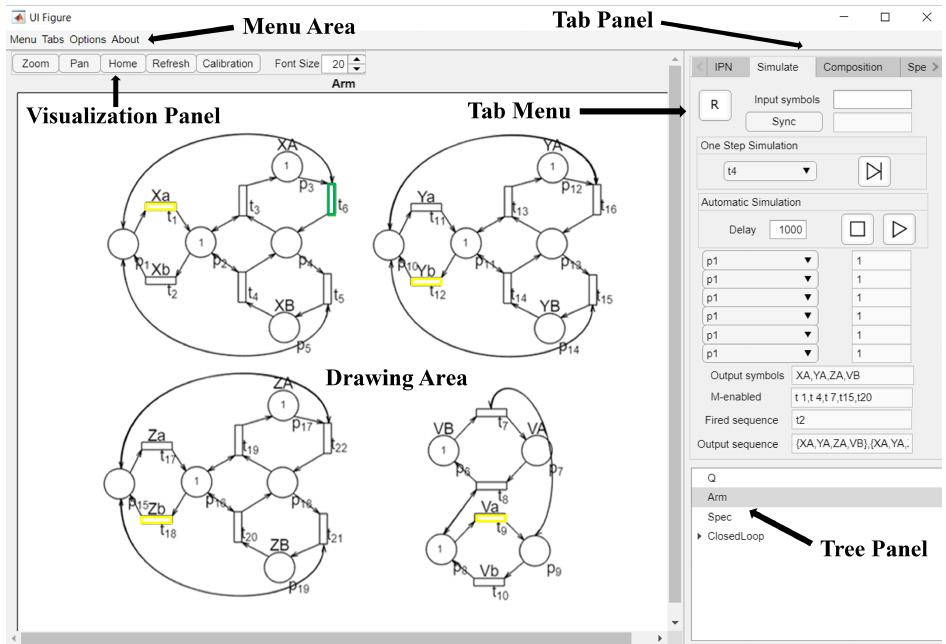
Figure 3. Workflow for the synthesis of controllers using regulation control framework.